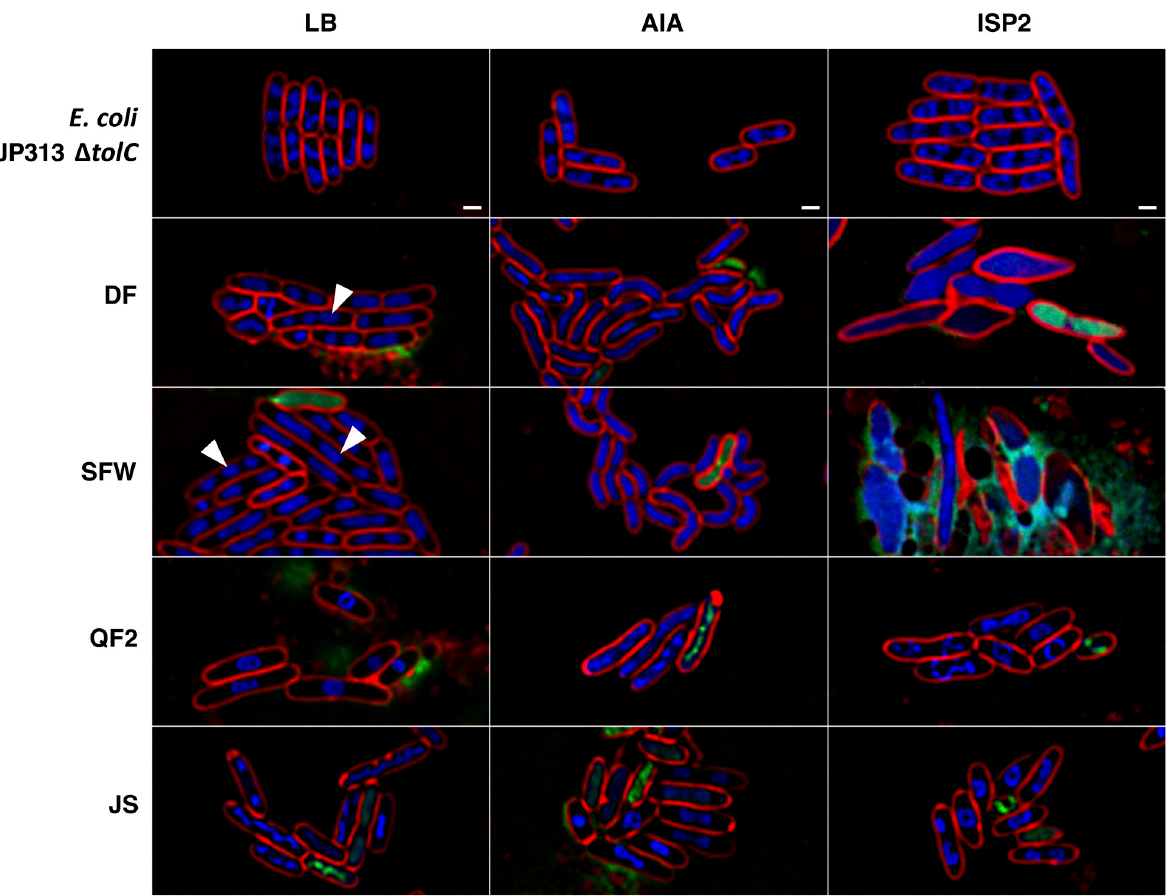
Fig 3. BCP phenotypes of E . coli JP313 Δ tolC exposed to natural products produced by four Streptomyces soil isolates grown on different solid media. Also displayed, are E . coli JP313 Δ tolC untreated controls grown on the tested media (LB agar, AIA, and ISP2 agar). White arrows indicate cells with three chromosomes. BCP images were collected after staining the cells with FM4-64 (red), DAPI (blue), and SYTOX-green (green). The scale bar represents one micron.